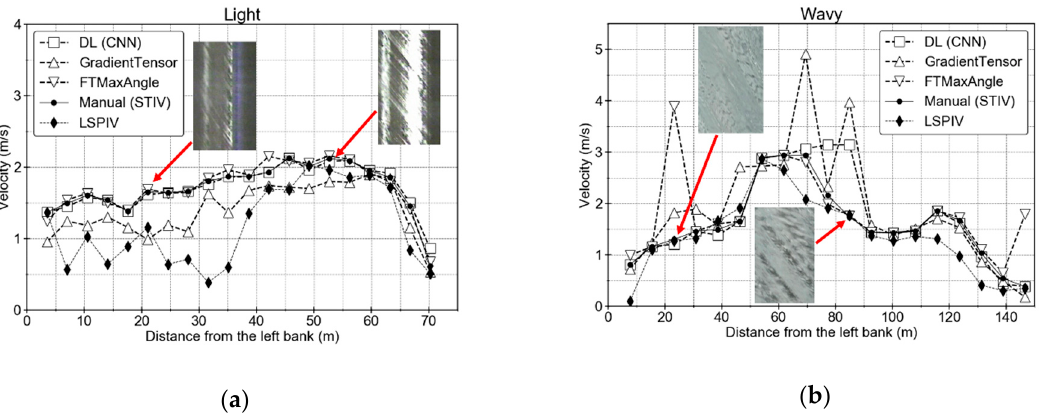
Figure 15. Comparison of cross-sectional flow velocity distributions: ( a ) light case; ( b ) wavy case. Table 5. The root mean square error (RMSE) of each case assuming the results of STIV manual analysis are the correct values. (The LSPIV results are excluded since the comparison is made when the results of STIV manual analysis are taken as the correct values).